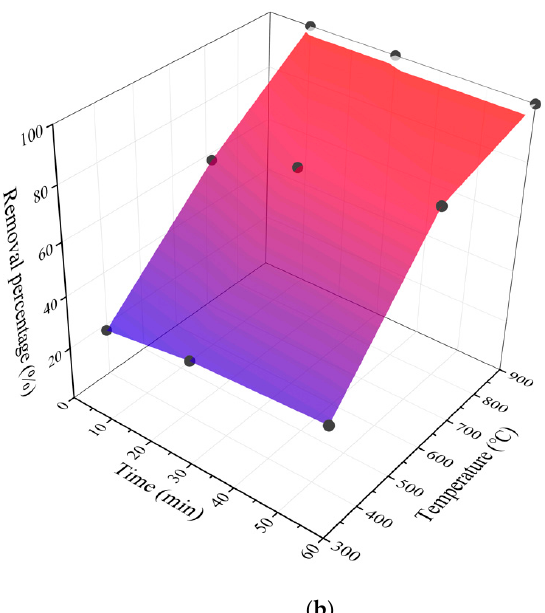
Figure 2. Removal percentage of 5000 ppm of pollutant with different treatment parameters. ( a ) Gasoline; ( b ) Diesel.